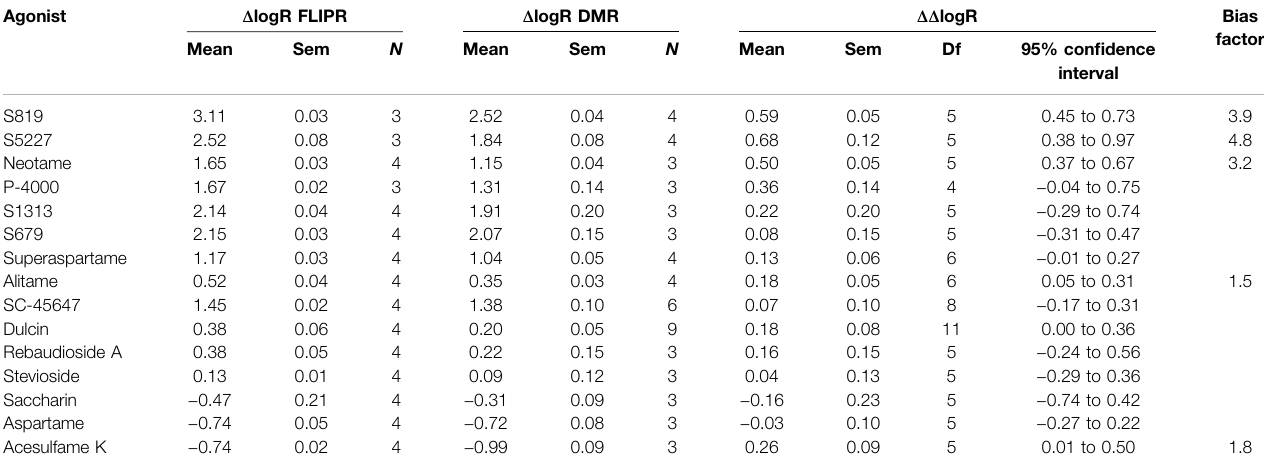
TABLE 2 | Transduction coef fi cients, Δ logR and ΔΔ logR values obtained from dose-response FLIPR-G α 15 and DMR data fi tting using the operational model. Ligand bias was estimated as described in Materials and Methods . Agonist Δ logR FLIPR Δ logR DMR ΔΔ logR Bias